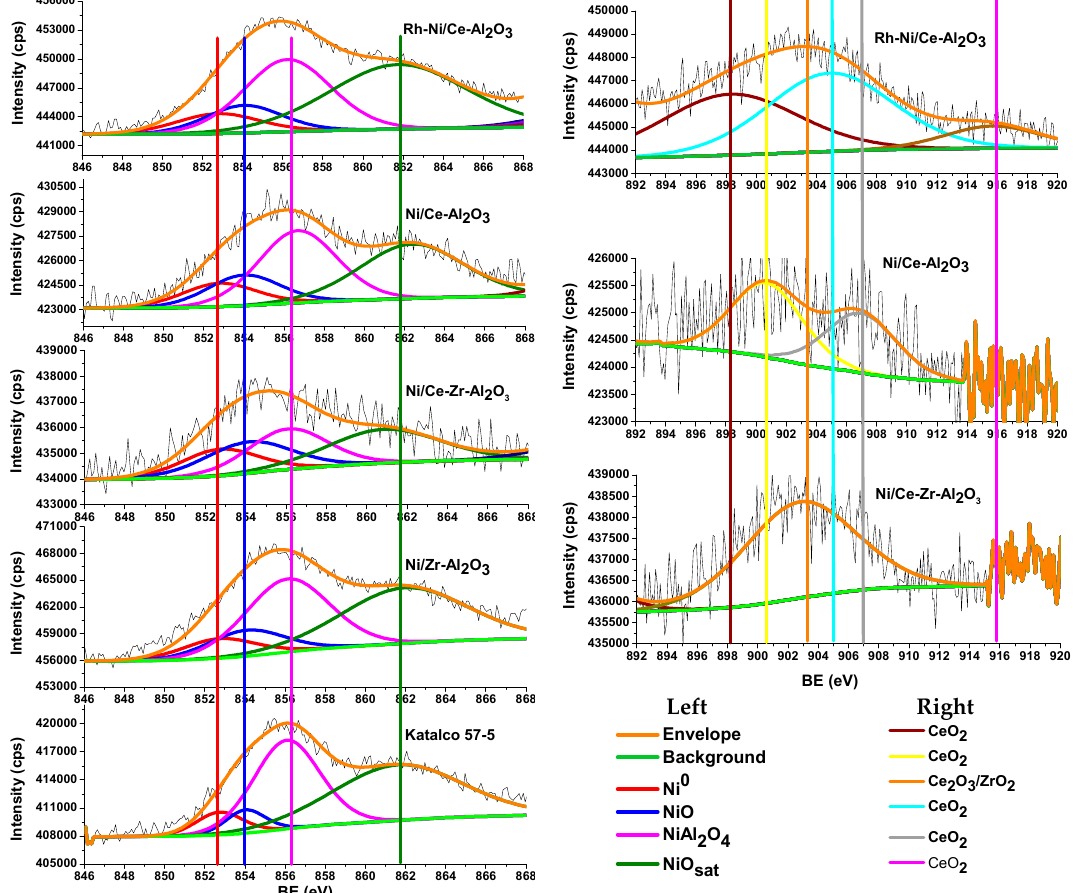
Figure A3. XPS spectra of freshly calcined catalysts.